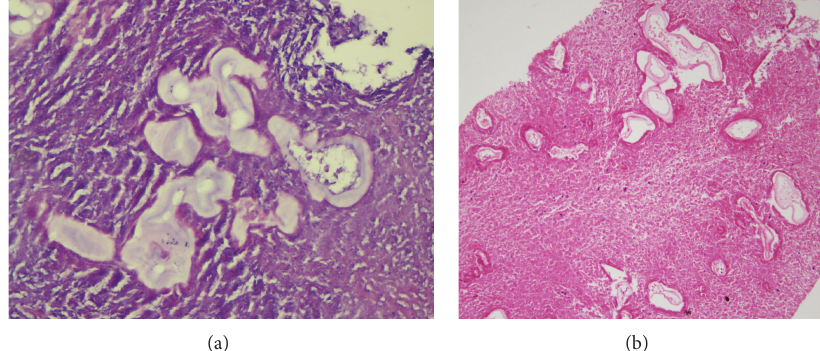
Figure 6: Pathologic examination revealed the germinative membranous structures of Echinococcus multilocularis in the liver parenchyma (400x magnification, hematoxylin and eosin staining) (a). Laminated membrane fragments are seen within the necrotic liver parenchyma of second case (20x magnification, hematoxylin and eosin staining)